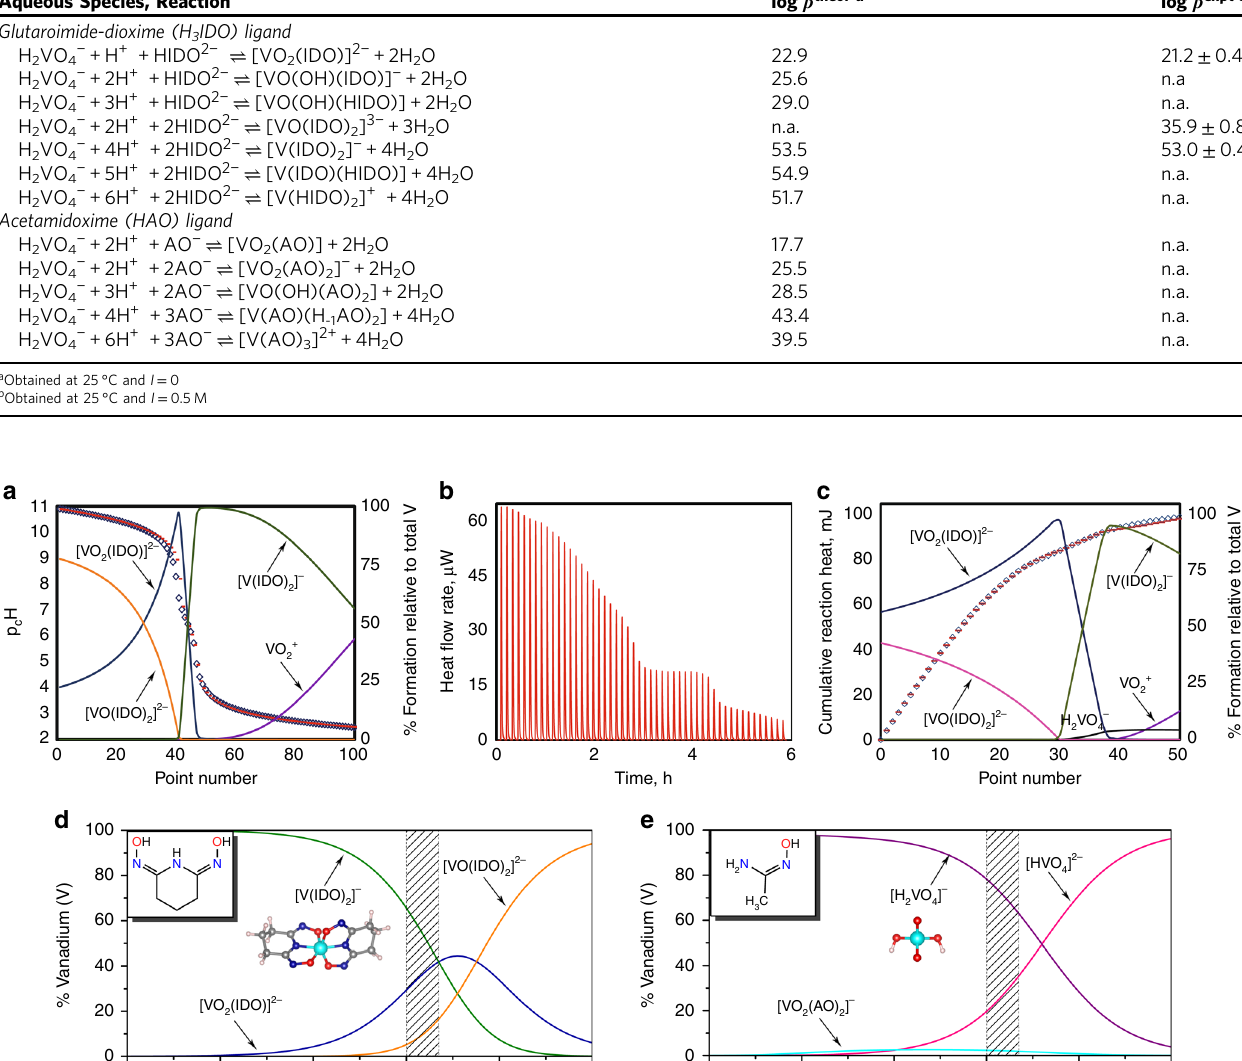
Table 1 Theoretically calculated and experimental stability constants (log β ) of vanadium complexes with glutaroimide-dioxime (H 3 IDO) and acetamidoxime (HAO) ligands Aqueous Species, Reaction log β theor a